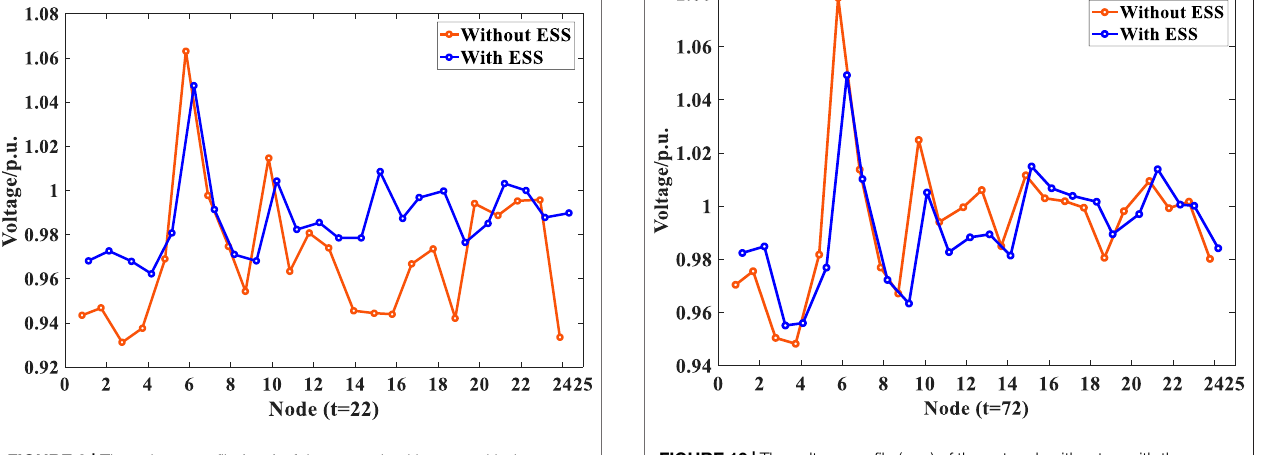
Frontiers in Energy Research |